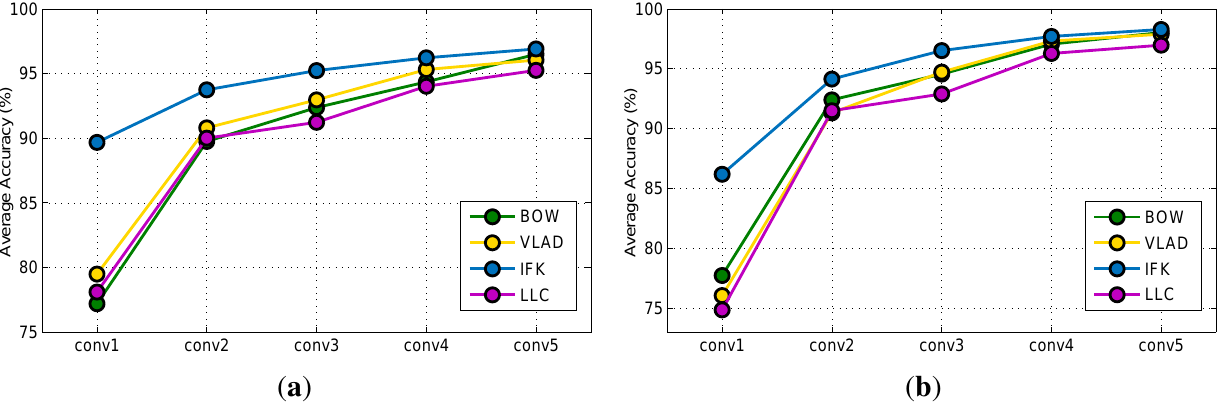
Figure 10. Classification performance on two datasets of dense CNN features extracted from each convolutional layer using different feature coding methods. Here, the VGG-M model is evaluated. The lengths of CNN features from the first to the last convolutional layer are 96, 256, 512, 512, and 512. ( a ) Performance on the UCM dataset for each convolutional layer; ( b ) Performance on the WHU-RS dataset for each convolutional